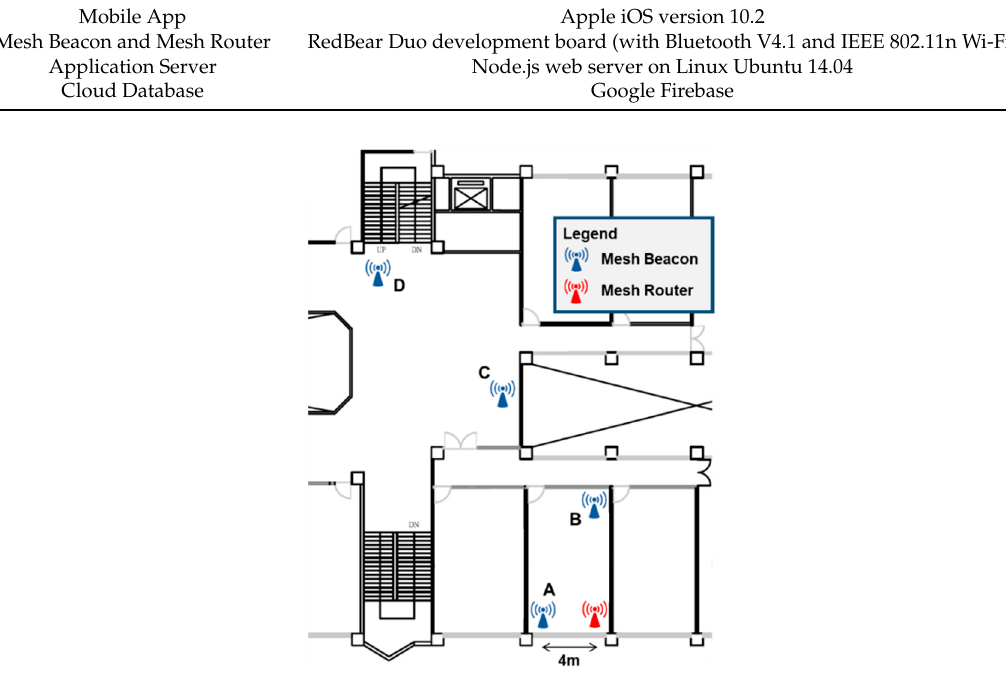
( c ) Figure 8. Screenshots of our Mobile App ( a ) during the locating process ( b ) physical location determined ( c ) acknowledgement message received.